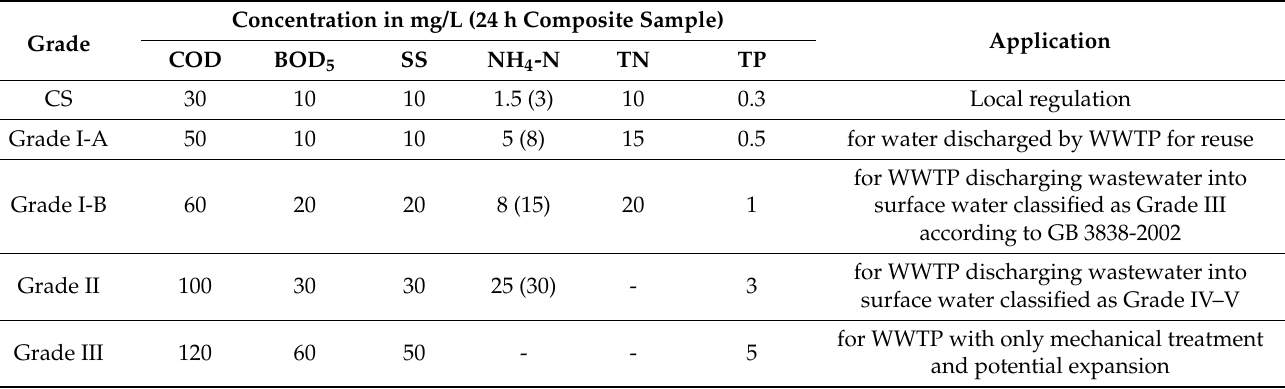
Table 1. Main basic parameters of the Chinese discharge standards of pollutants for municipal WWTP according to norm GB 18918-2002 [26] and the local city standard (CS) in the Tai Hu basin as an example.